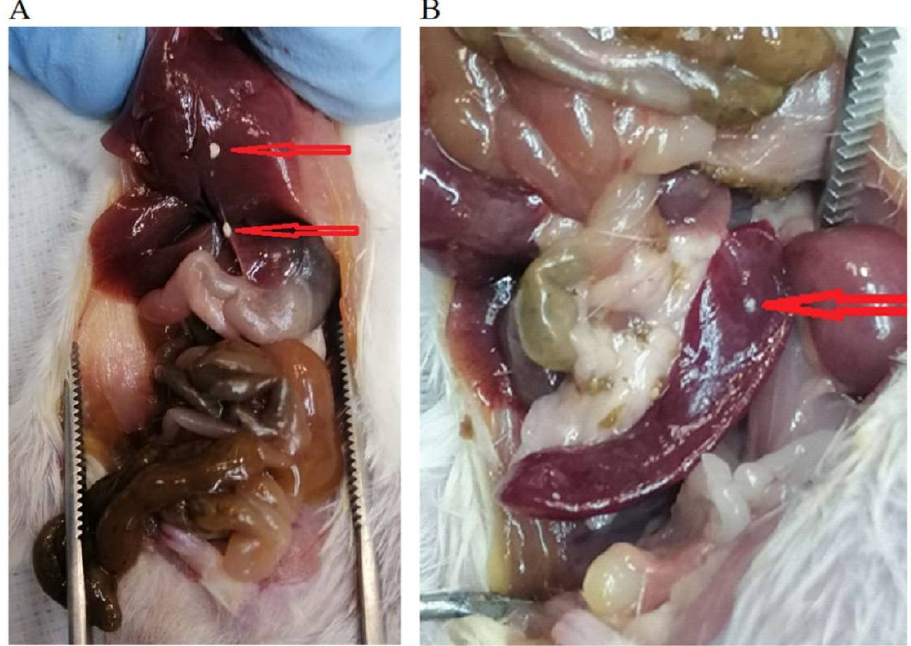
Figure 18. Organs of the mouse abdominal cavity during autopsy. Animal #12 (group 1, 4e ). Macropreparation. There are no signs of local inflammation, adhesion, or sufficient development of adipose tissue. ( A )—x 2. No signs of acute intoxication. The arrows indicate the agglomerates of the injected compound observed on the surface of the liver. ( B )—x 4. The area of the gastrointestinal angle and the left kidney. The arrows indicate the agglomerates of the injected compound observed on the surface of the spleen.